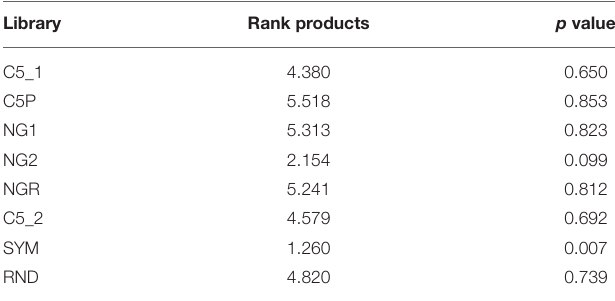
TABLE 2 | Rank product test of three criteria for optimal mimotope library. Library